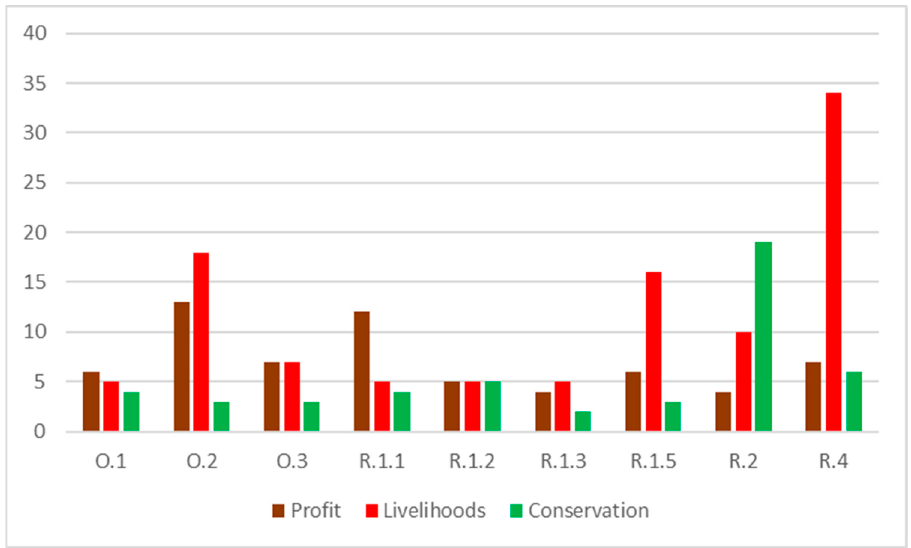
Figure 2. Code segment frequency and core beliefs.